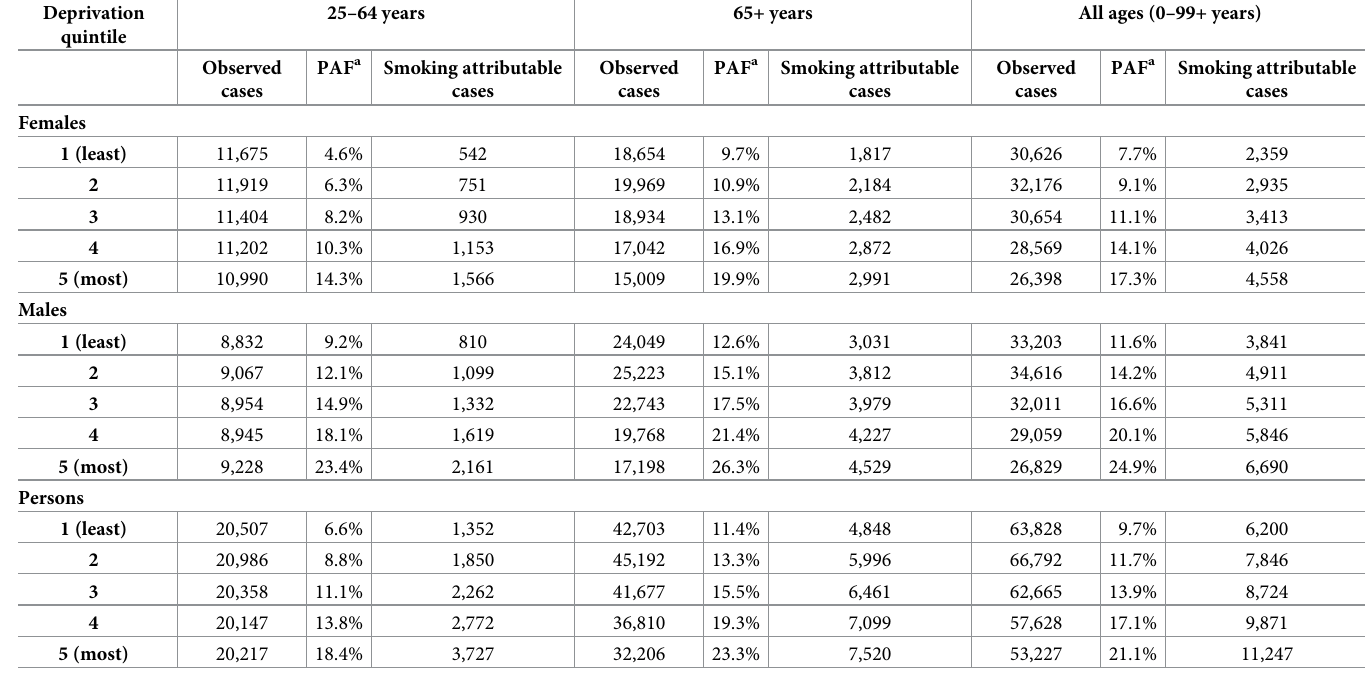
Table 1. Average number and proportion of smoking-attributable cancer cases per year by sex, age and deprivation quintile, England, 2013–2017. Deprivation